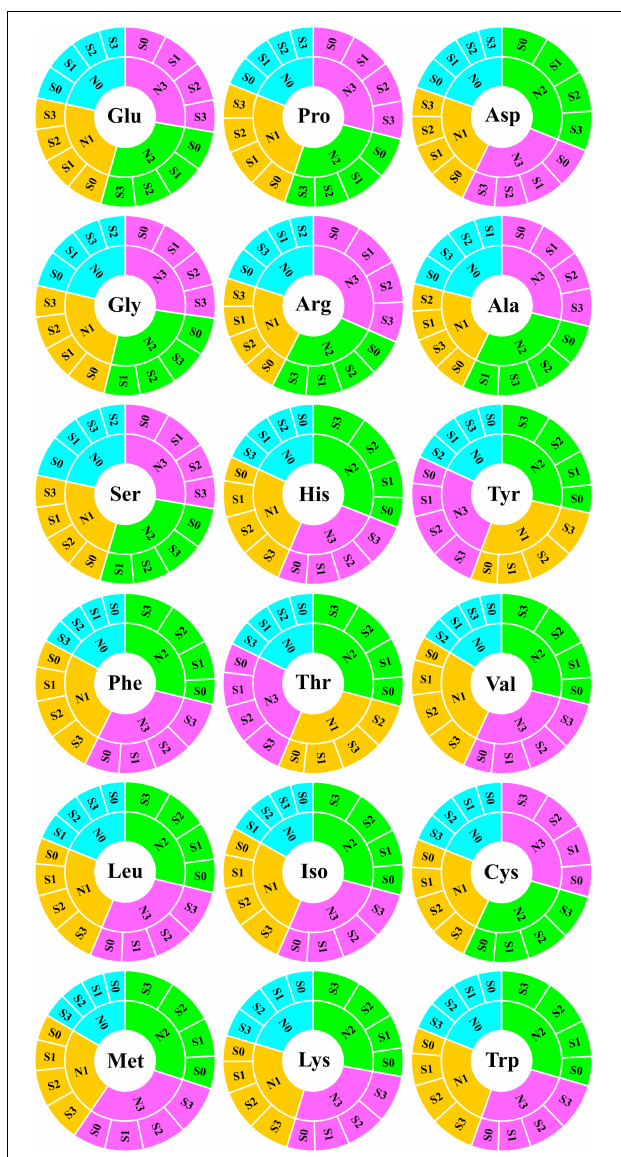
FIGURE 5 | Analysis of amino acids in maize grains. In this image, the abbreviations at the center of the circle represent the amino acid type. The fan-shaped regions of different colors indicate the amino acid concentration of grains at different N rates, and each grid surrounding the outer ring of the same color region indicates the amino acid concentration of different S rates at the same N level. Both the fan-shaped area and the outer ring grid are arranged in descending clockwise order according to the area size. Glu, glutamate; Pro, proline; Asp, aspartic acid; Gly, glycine; Arg, arginine; Ala, alanine; Ser, serine; His, histidine; Tyr, tyrosine; Phe, phenylalanine; Thr, threonine; Val, valine; Leu, leucine; Iso, isoleucine; Cys, cysteine; Met, methionine; Lys, lysine; Trp,